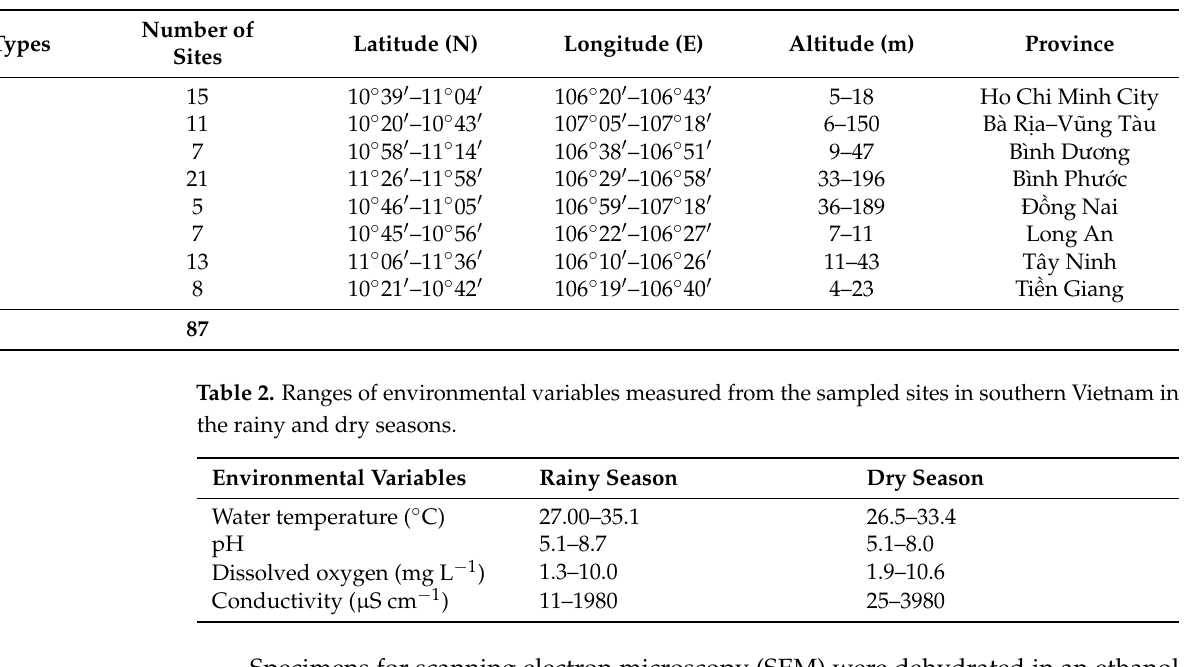
Table 1. Habitat types, number of sites, coordinate ranges, and altitudes of the sampling sites in eight provinces of southern Vietnam. The habitat types are represented as L = lake, P = pond, C = roadside canal, Ri = river, and Rf = rice field.